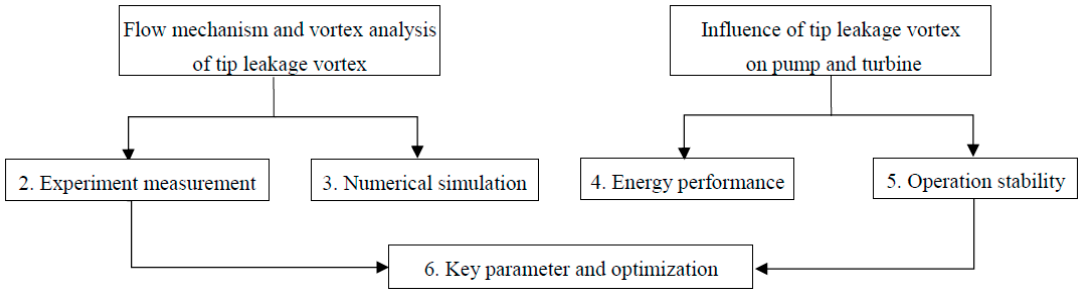
Figure 4. Sketch map of the paper structure.